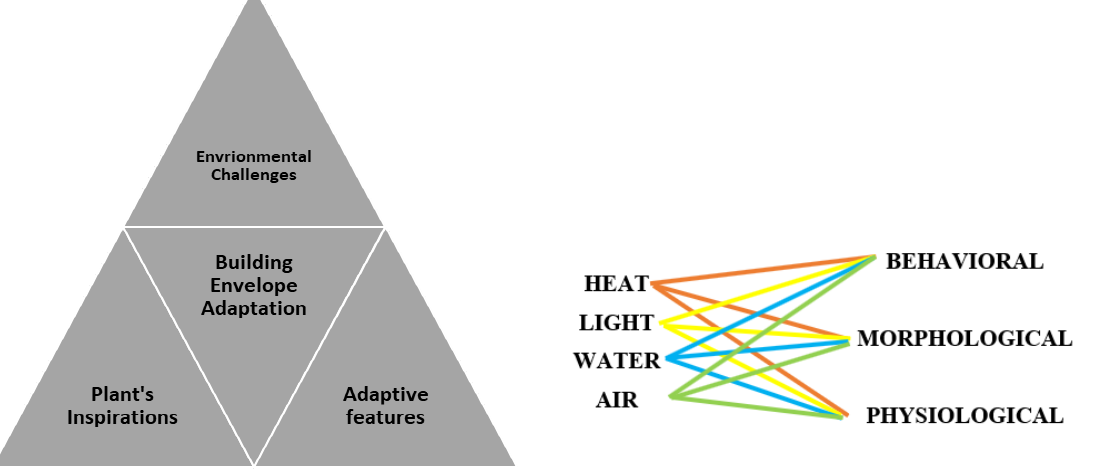
Figure 8 : The interrelation between the methodology pillars (The researcher,